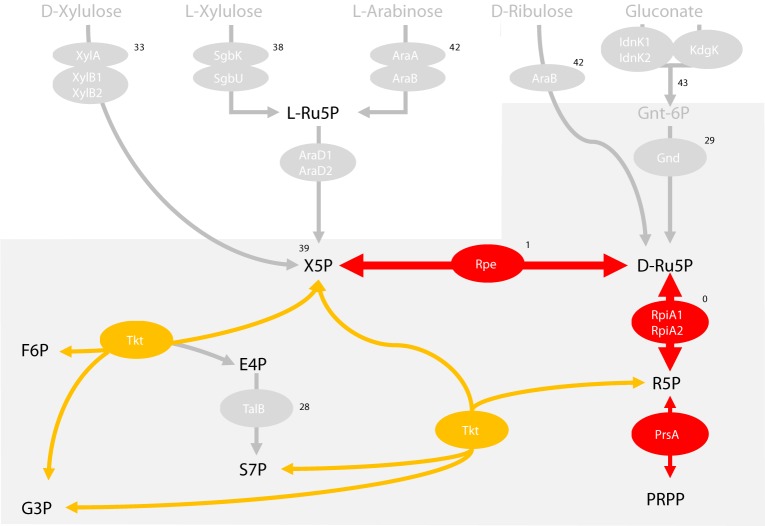
Pentose-related metabolic pathways that might have a role in flea blockage.The figure shows the flea blockage rate for mutants lacking D-xylulose (ΔxylAB1), L-xylulose (ΔsgbK-sgbU), arabinose/D-ribulose (ΔaraAB), D- and L-xylulose and arabinose/D-ribulose (ΔaraD1 ΔaraD2 ΔxylB1 ΔxylB2) pathways with or without Rpe (ΔaraD1 ΔaraD2 ΔxylB1 ΔxylB2 Δrpe), gluconate import (ΔidnK1 Δindk2 ΔkdgK) or use via the upper part of the pentose phosphate pathway (Δgnd), ΔtalB, Δrpe or ΔrpiA ΔrpiA2). Grey arrows indicate pathways that are not important for flea blockage. The other reactions are considered to be important for flea blockage because the mutant either (i) does not block fleas (Δrpe and ΔrpiA ΔrpiA2 mutants), (ii) was highly deficient for growth in vitro (ΔtktA) (see supplementary text) or (iii) could not be deleted (ΔprsA), presumably because it is essential (as reported for E. coli). The grey area encloses the enzyme reactions of the pentose phosphate pathway.